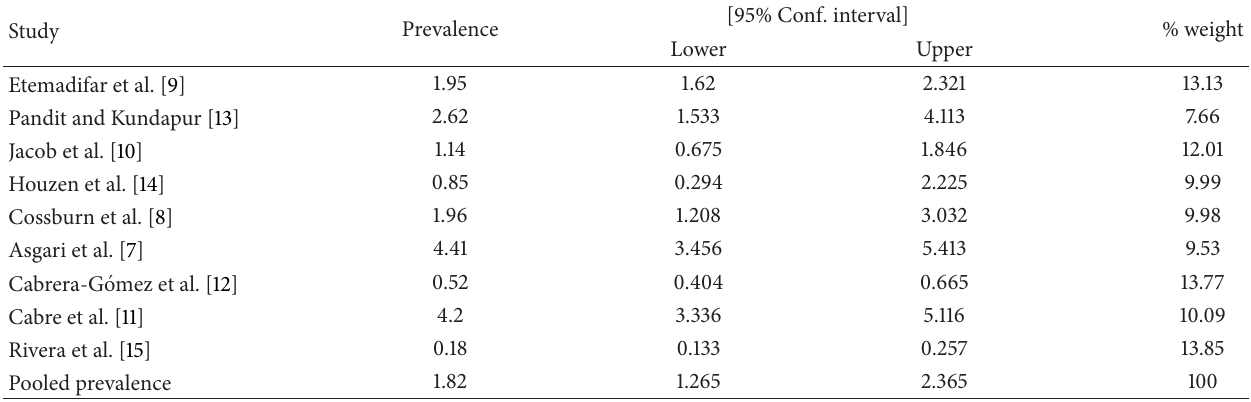
Table 2: Prevalence of NMO in studies with a random effect